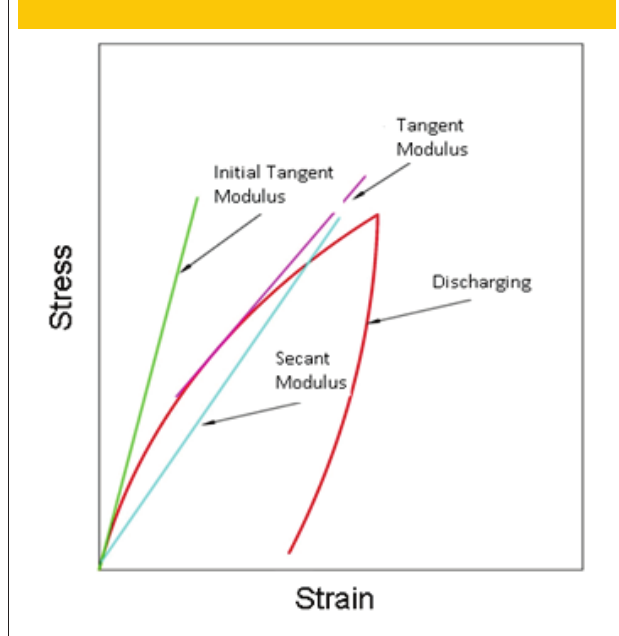
Figure 2 – Typical stress-strain curve of